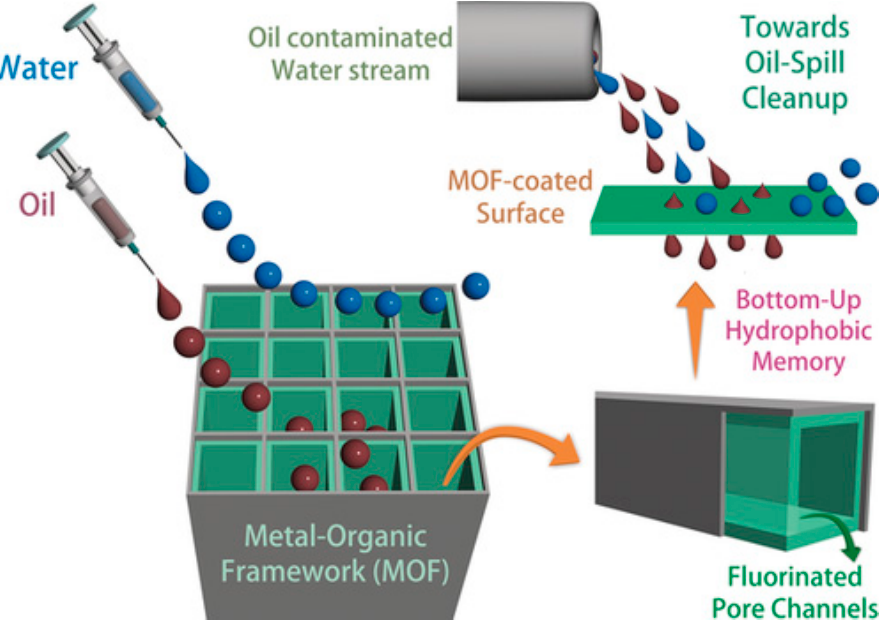
Figure 5. ( a ) Orthographic surface view of as-synthesized UHMOF-100 a; and ( b ) a single fluorous pores of UHMOF-100; ( c ) decorated fluorous voids on the Connolly surface; ( d ) PXRD profiles for different phases of UHMOF-100, validating its soft porous crystallinity and water stability. Reprinted with permission [32] Copyright 2016, Wiley—VCH.